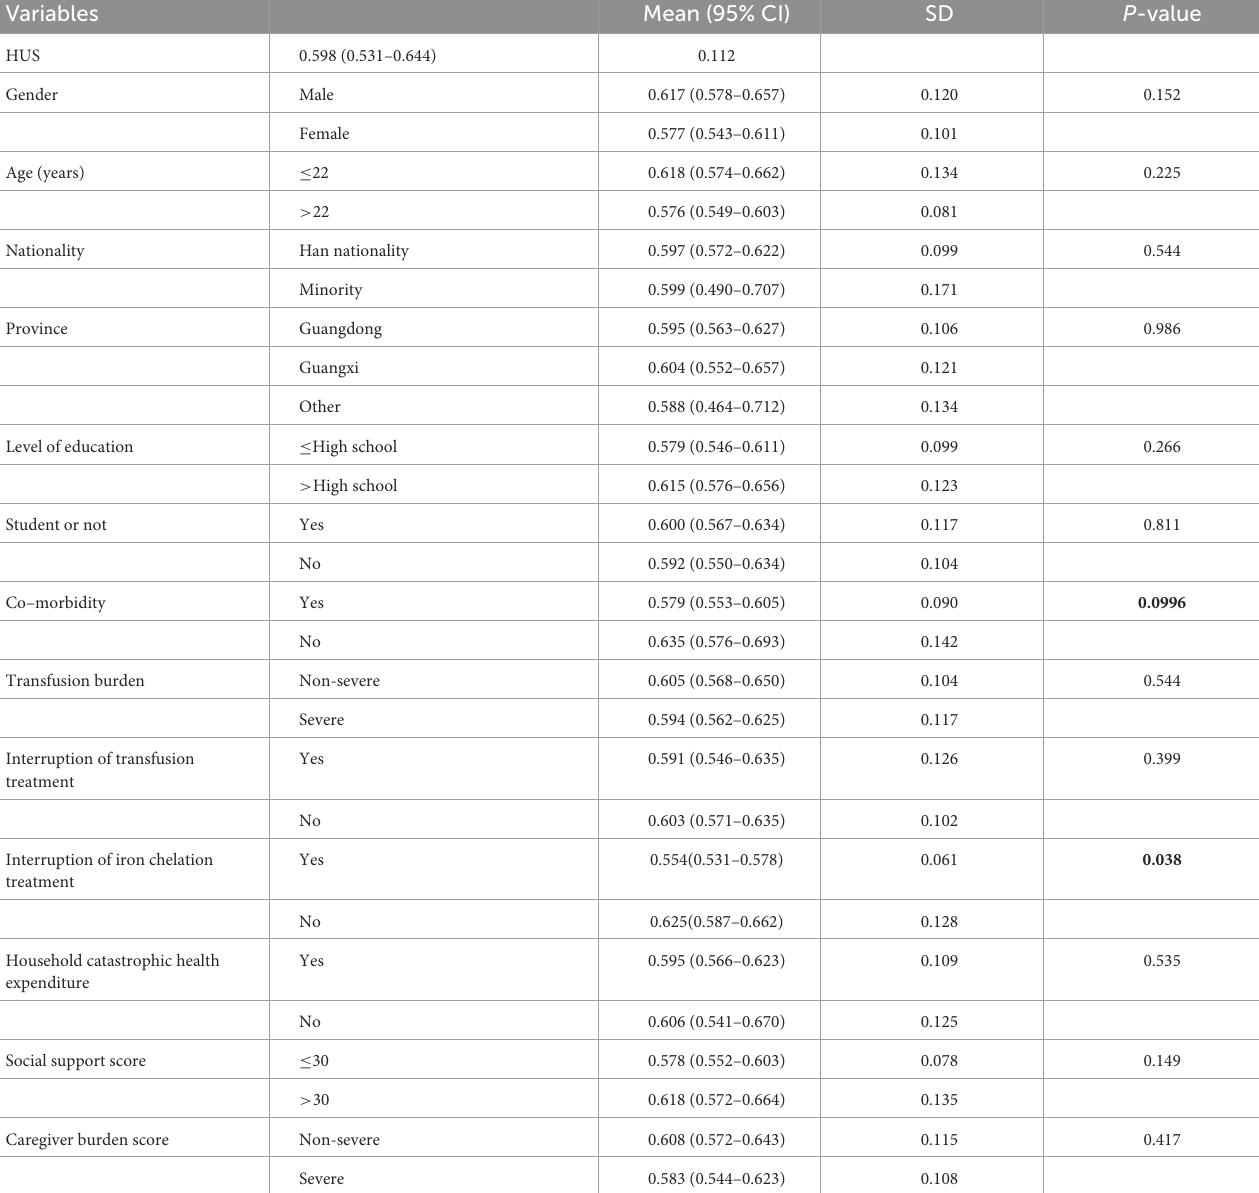
TABLE 3 Differences in health state utility scores across subgroups for adult patients with β -thalassemia major ( n =